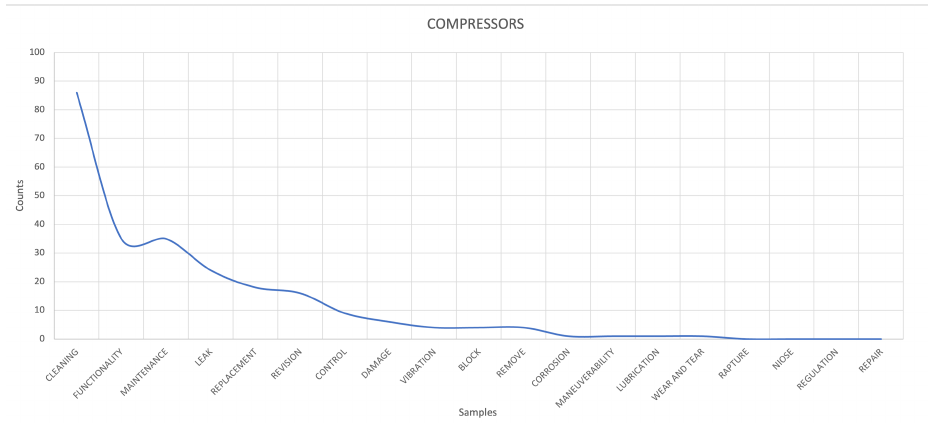
Figure 6. Frequency distribution of the fault category with respect to the notices related to compressors.